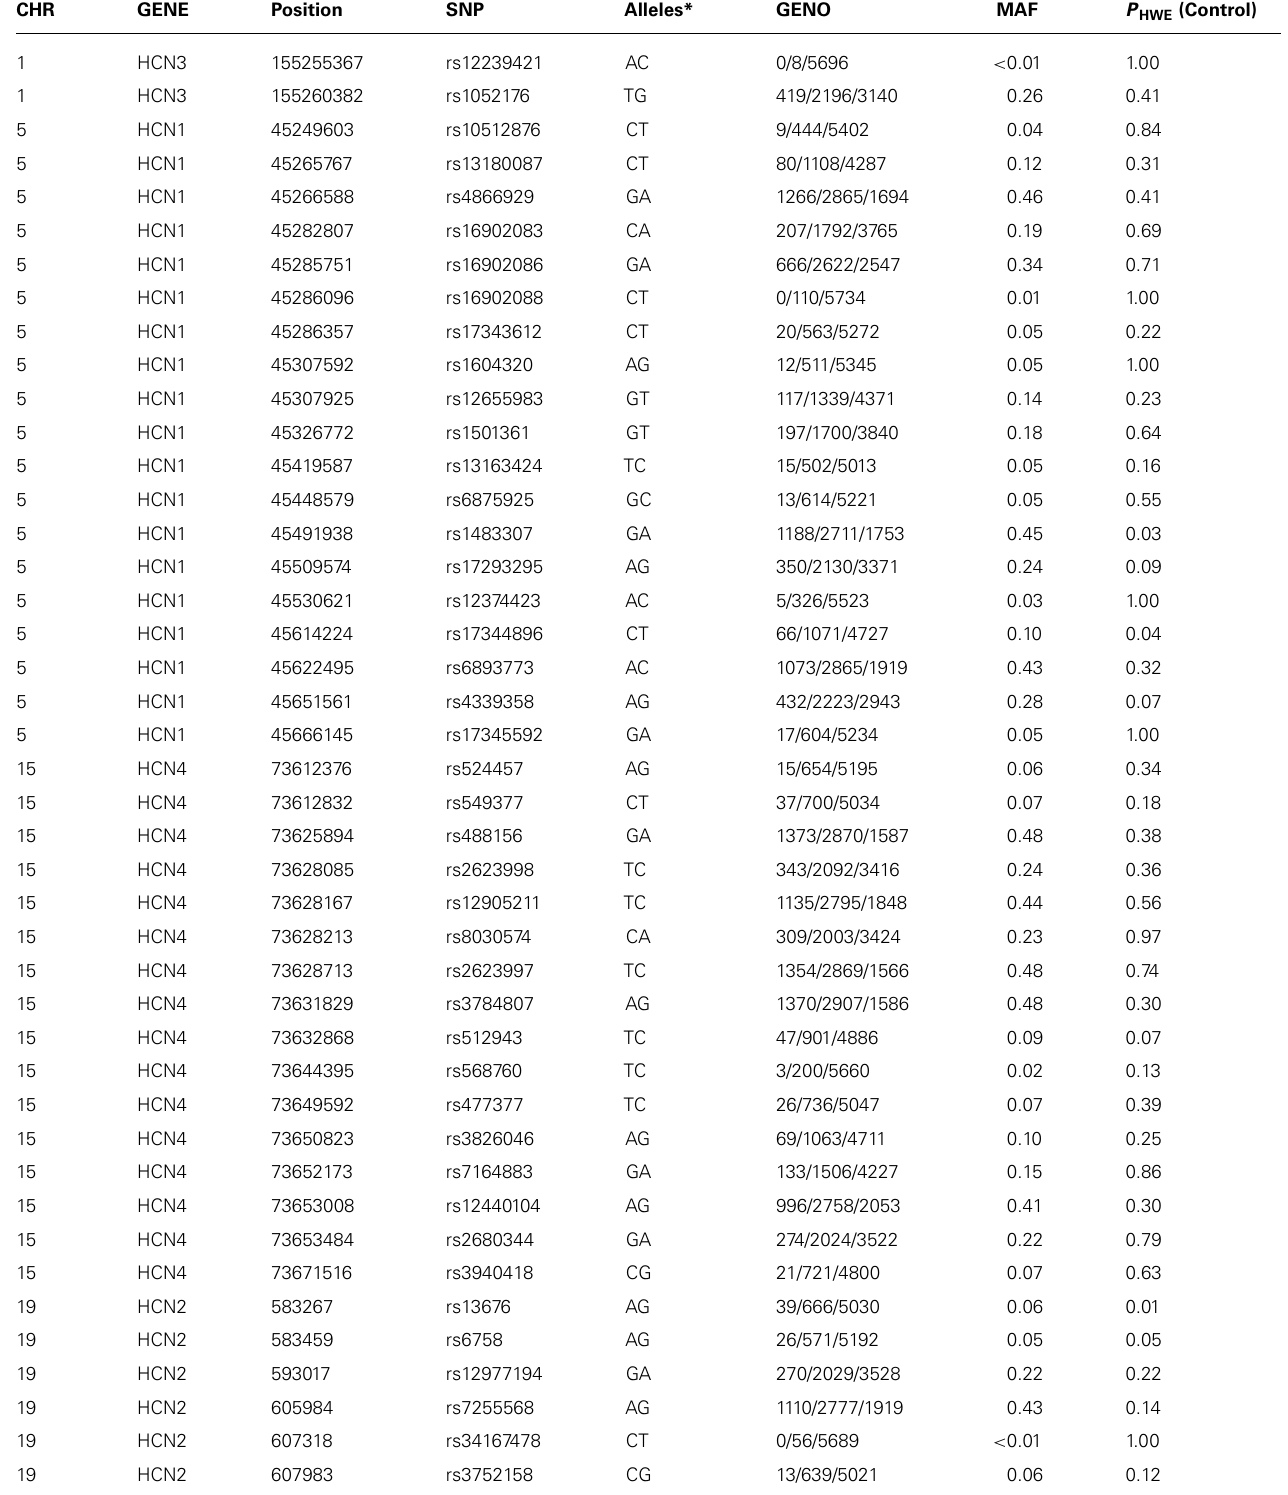
Table 2 | HCN1–4 haplotype-tagging